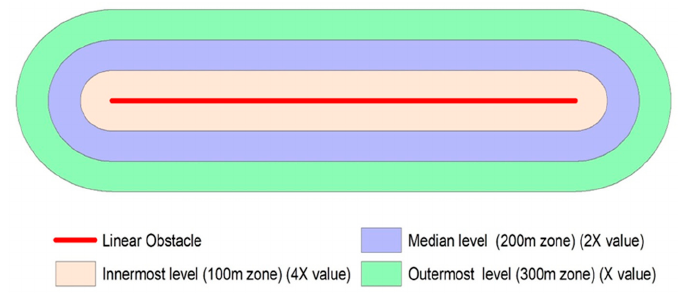
Figure 7. Vertically crossed obstacles.